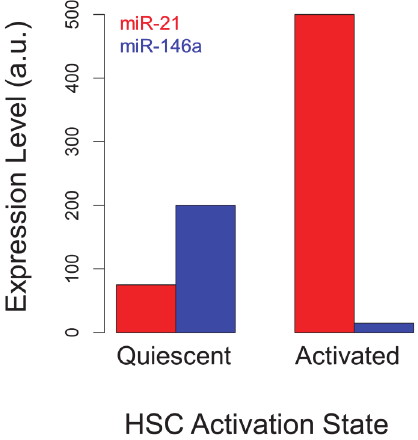
Figure 1. Changes in microRNA expression levels between quiescent and activated hepatic stellate cells. Data are derived from published microarray data on microRNA expression in primary hepatic stellate cells collected from Wistar rats (Gene Expression Omnibus accession GSE19462)